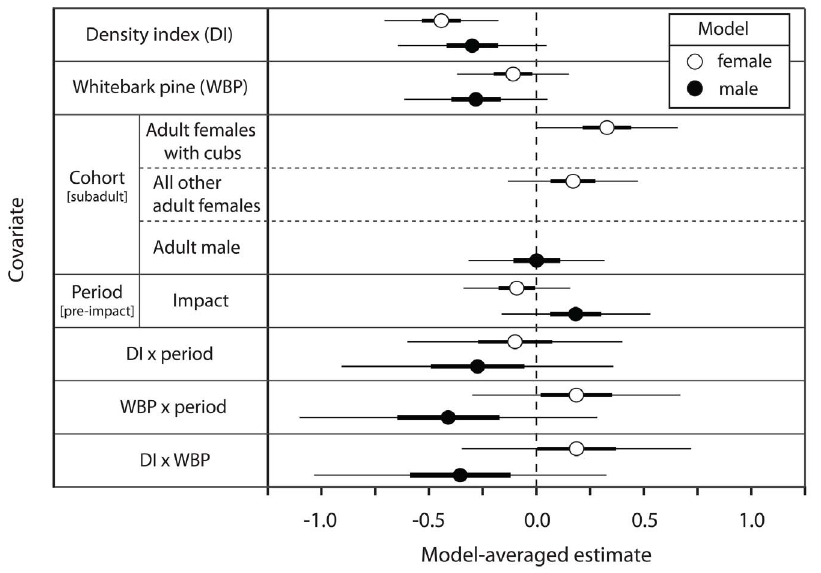
Figure 1. Beta estimates for covariate effects on home-range size of female and male grizzly bears. Model-averaged beta estimates from linear mixed-effects models of cohort, period (pre-whitebark pine [WBP] impact [1989–1999] and WBP impact [2007–2012]), density index (DI), and proportion of WBP in home range (adjusted for mortality during impact period ) on home-range size (km 2 ; 95% a -local convex hull) of female (open circles) and male (gray circles) grizzly bears in the Greater Yellowstone Ecosystem. Reference groups for cohort and period are in brackets. We applied z-score transformations to WBP and DI.